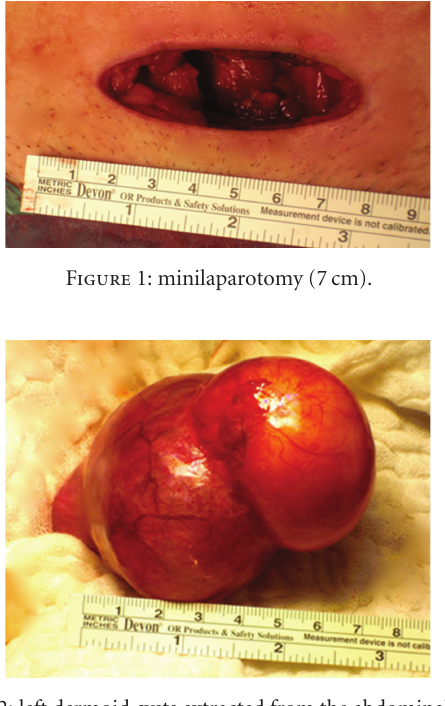
Figure 4: right dermoid cyst extracted from the abdominal cavity. Sterile pads were placed around the cyst to avoid, in case of a rupture, a contamination of the abdominal